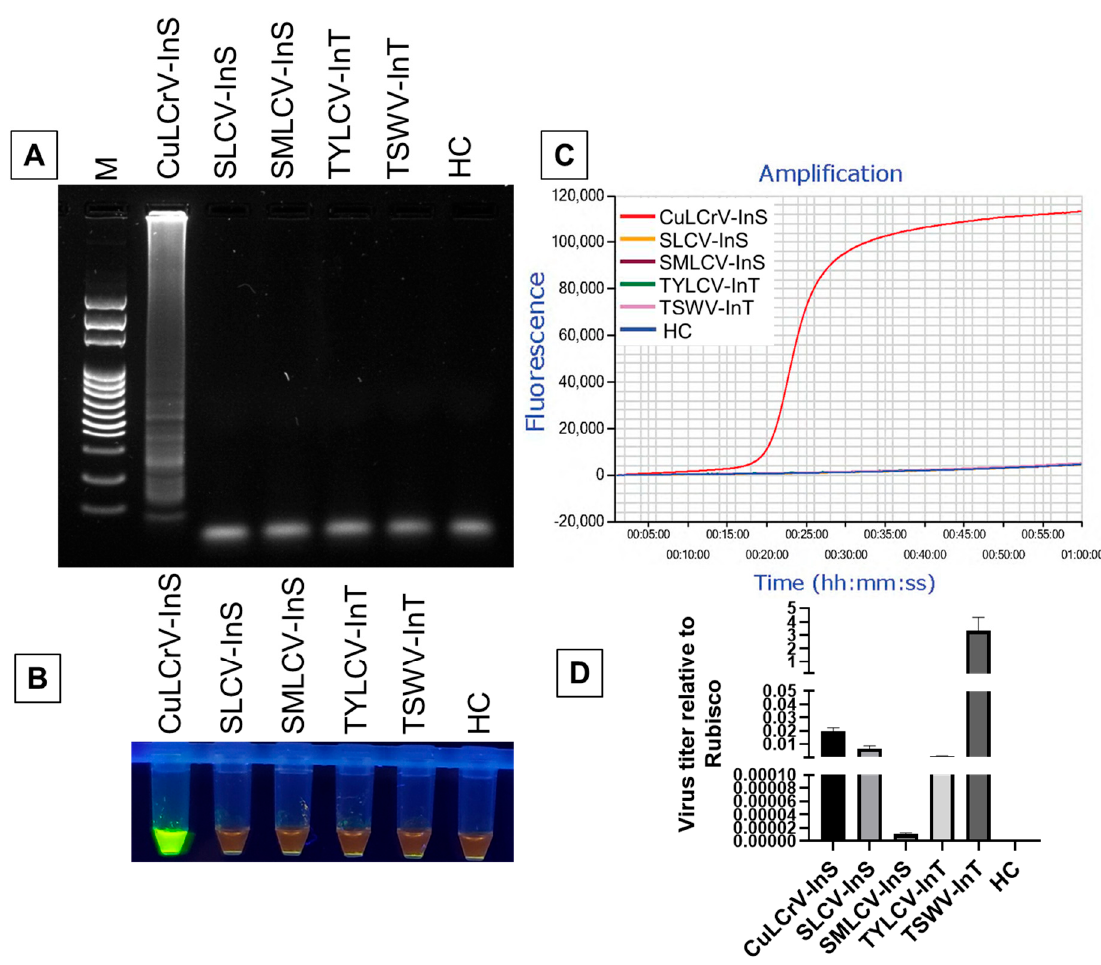
Figure 3. The specificity of the LAMP assay for the detection of CuLCrV. Amplified products were analyzed using agarose gel electrophoresis ( A ), visual inspection with SYBR ™ green 1 DNA gel staining ( B ), and real-time amplification using Genie ® III ( C ). The virus titer was calculated using qPCR relative to internal control gene Rubisco ( D ). We used CuLCrV-InS: CuLCrV-infected squash, SLCV-InS: SLCV-infected squash, SMLCV-InS: SMLCV-infected squash, TYLCV-InT: TYLCV-infected tomato, TSWV-InT: TSWV-infected tomato, HC: healthy squash leaf as a negative control, and M: 100 bp DNA ladder ( A ). The fluorescent green-colored products could be visualized after SYBR ™ green 1 DNA gel staining under UV light while negative reactions remained orange in color ( B ). Successful LAMP amplification is demonstrated by curve amplified by Genie ® III (C).